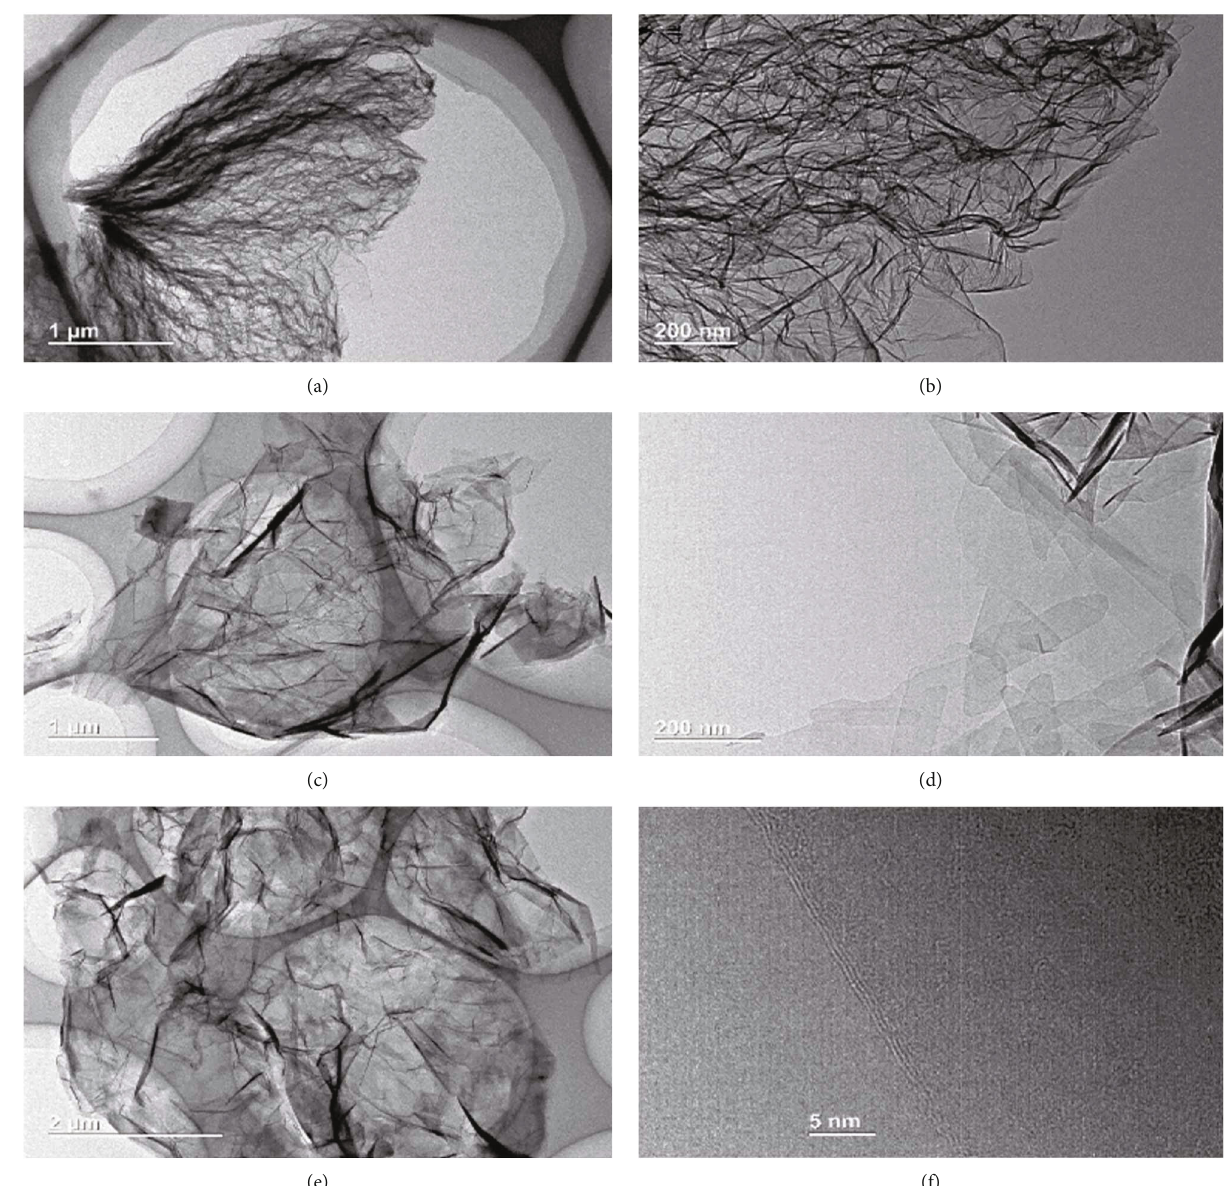
Figure 2: TEM morphology and HRTEM structure of graphene and graphitized